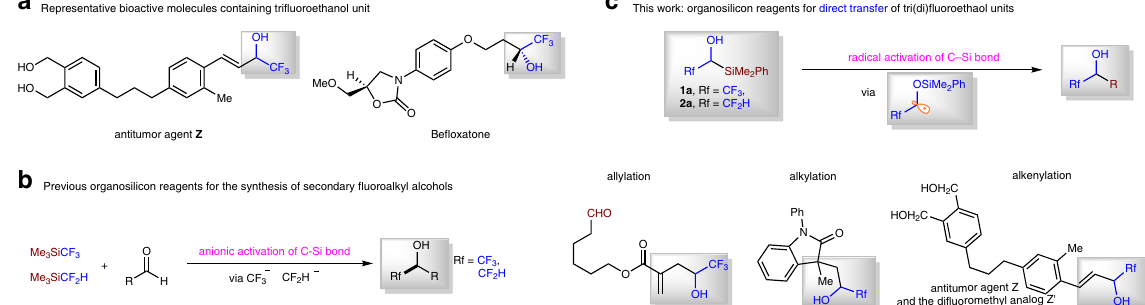
Fig. 1 Secondary fl uoroalkyl alcohol synthesis with fl uorinated organosilicon reagents. a Representative bioactive molecules containing tri fl uoroethanol unit. b Organosilicon reagents has been used in the synthesis for secondary fl uoroalkyl alcohols via α - fl uoro carbanions transfer. c Organosilicon reagents for direct transfer of tri(di) fl uoroethanol units via radical activation strategy is developed (this